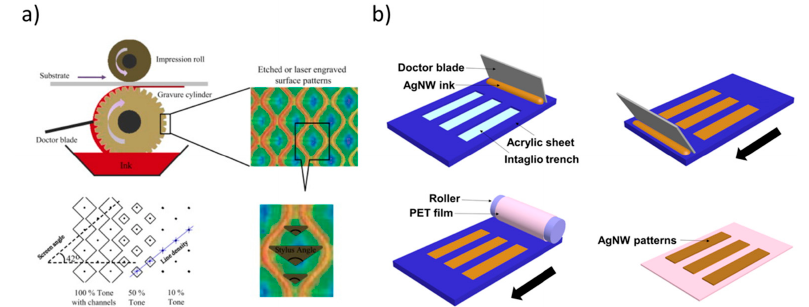
Figure 3. ( a ) At the top, schematic representation of the gravure printing process, depicting engraved surface patterns. At the bottom, main parameters involved in the patterning process (tone, screen angle, line density and stylus angle). Reprinted from reference [45], Copyright (2013), with permission from Elsevier. ( b ) In the case of the inverse gravure printing, the patterns on a flat plate are transferred to the flexible substrate mounted onto a roller. Reprinted from reference [47] under a Creative Commons Attribution 4.0 International